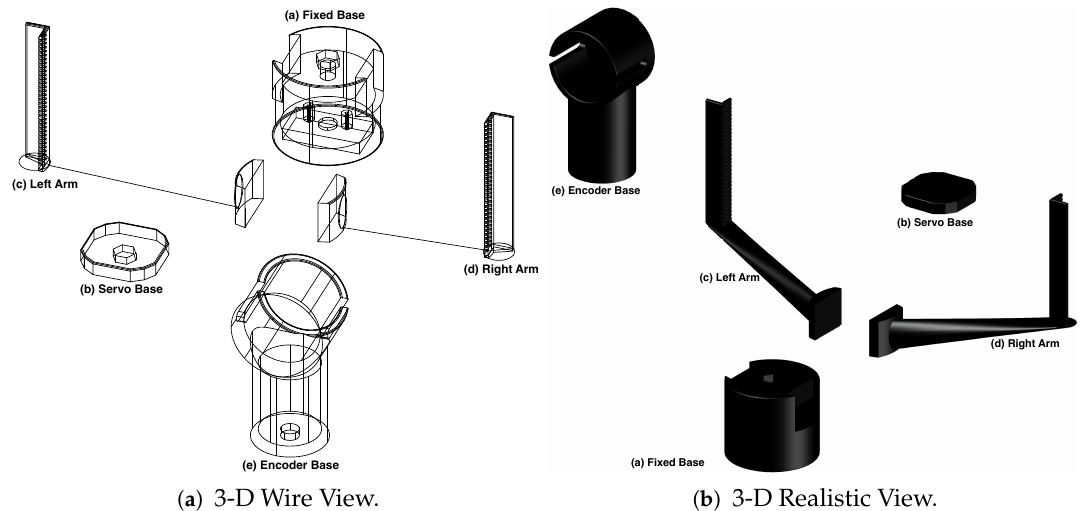
Figure 2. 3-D Design (Design implemented as part of the